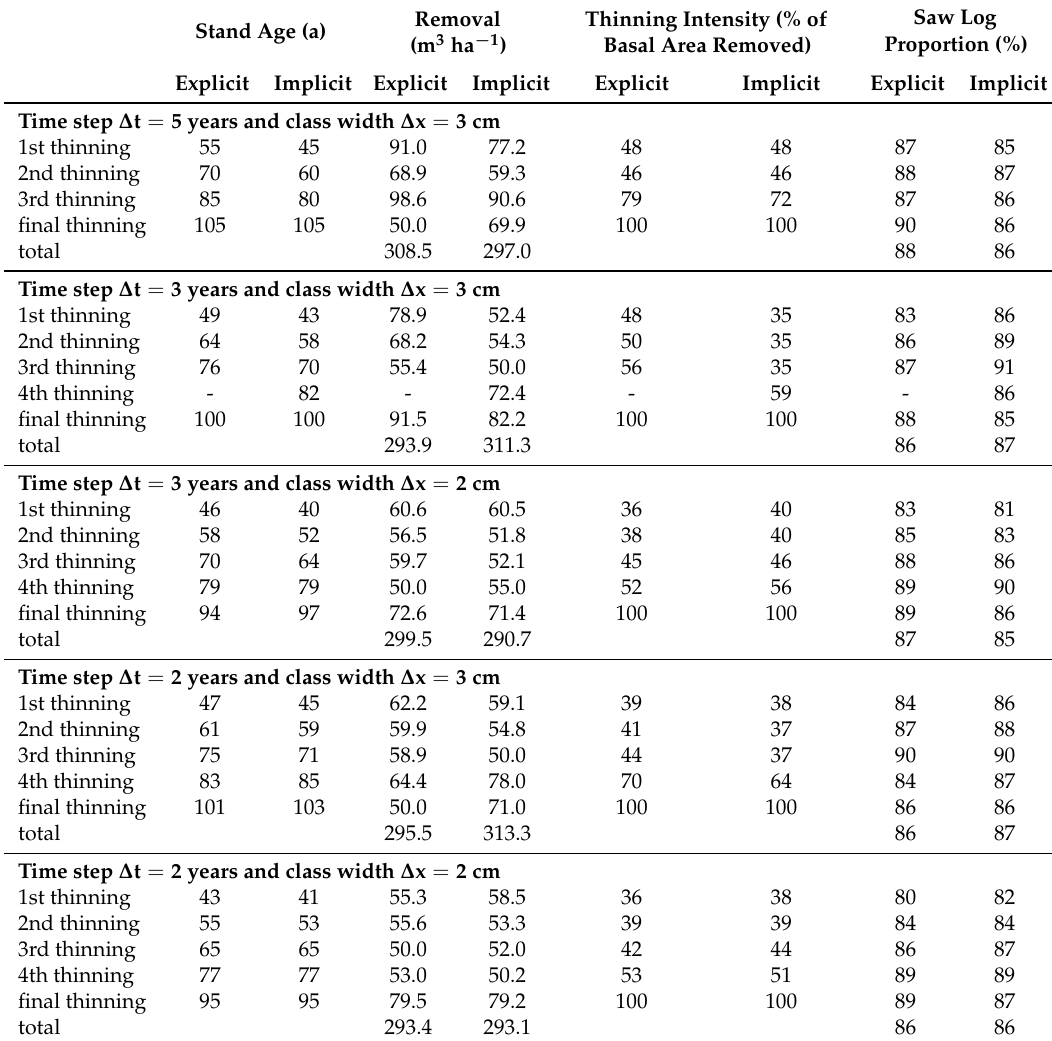
Table 2. Optimal stand-level managements generated by explicit (7) and implicit (11) approximation of the forest growth model (4). Initial density is 1000 stems ha − 1